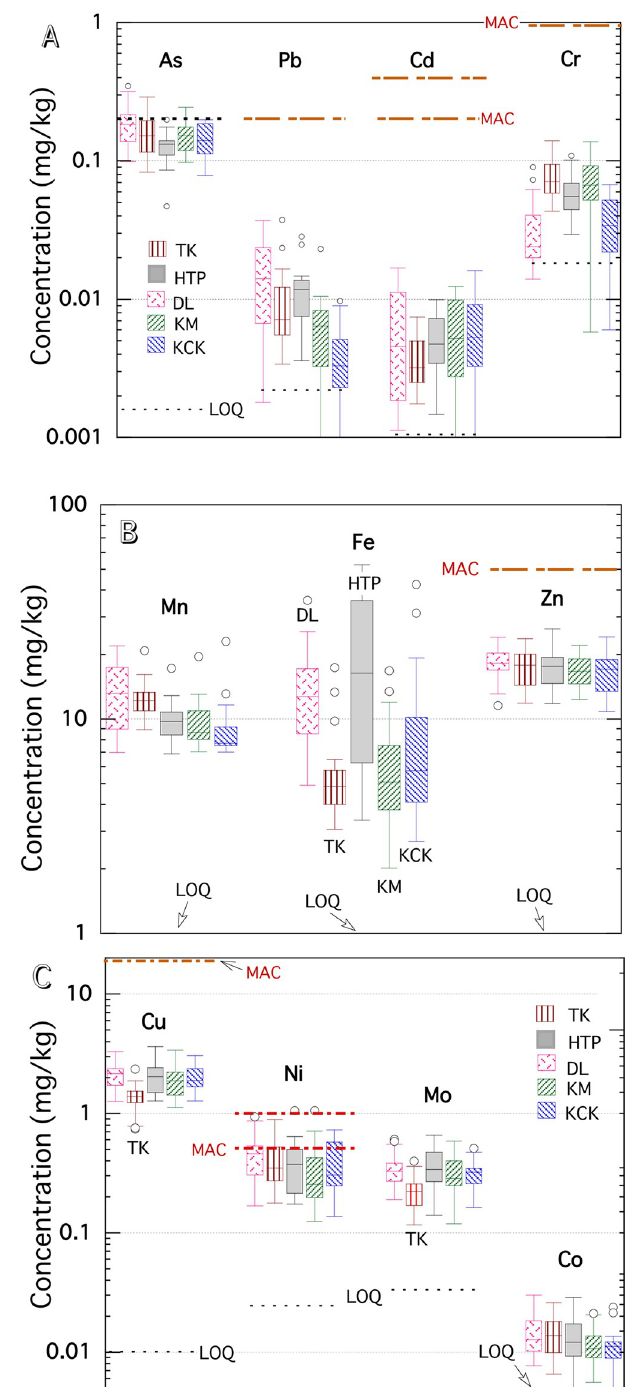
Fig 2. Box plot of each element concentration in rice samples from five townships. A) As, Pb, Cd, and Cr; B) Mn, Fe and Zn; C) Cu, Ni, Mo and Co. The horizontal line in a shaded box encloses 50% of the data, indicating the median value. The box’s top and bottom edges (UQ and LQ) mark 75 and 25 percentiles, and the difference between UQ and LQ is the interquartile distance (IQD). The lines extending from each box’s edges indicate the maximum and minimum values between "UQ + 1.5 x IQD" and "LQ—1.5 x IQD" values. Any outlier value outside the range is displaced as an individual point. The dash-dot and dotted horizontal lines at each element are the maximum allowable concentrations (MAC) in white rice grain [15, 31] and the limits of detection (LOD) of the analysis of this study, respectively (Table 1).